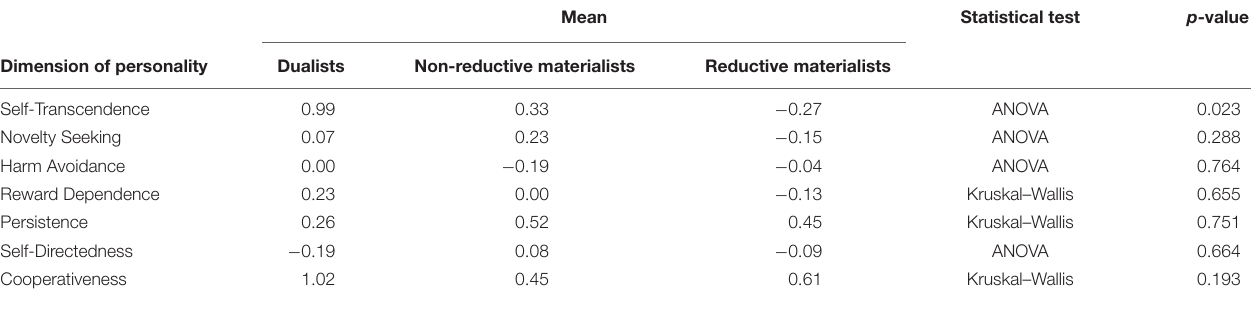
TABLE 2 | Comparison of the three groups of mind-body inclinations: means of all personality dimensions and results of tests. Mean Statistical test p